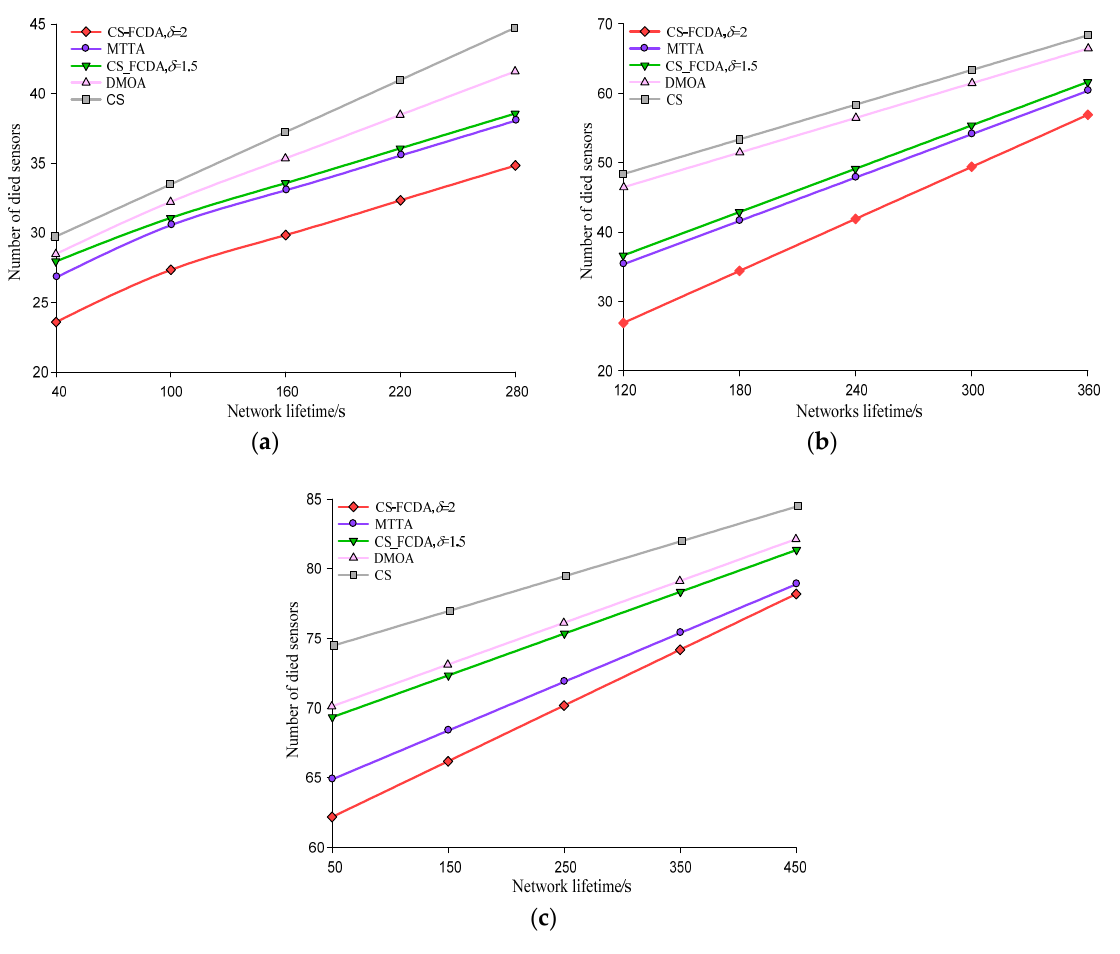
Figure 6. Comparison on network lifetime. ( a ) Comparison on network lifetime when N = 100. ( b ) Comparison on network lifetime when N = 300. ( c ) Comparison on network lifetime when N = 500.